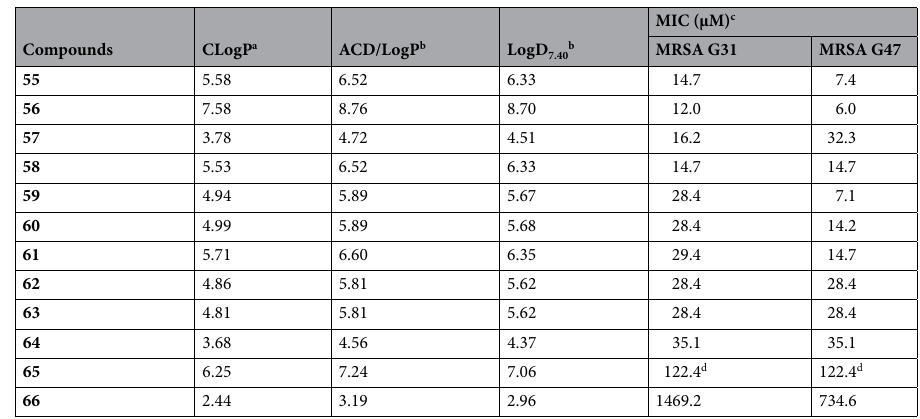
Table 6. Physico-chemical parameters and antimicrobial activities of compounds 55 to 66 15 . a The CLogP values were calculated using software ChemBioDraw Ultra 12.0. b The ACD/Log P and LogD 7.40 values were calculated using software ACD/Labs 6.0. c MIC, minimum inhibitory concentration; MRSA G31 and G47, methicillin-resistant Staphylococcus aureus G31 and G47. d Both MICs of compound 65 against MRSA G31